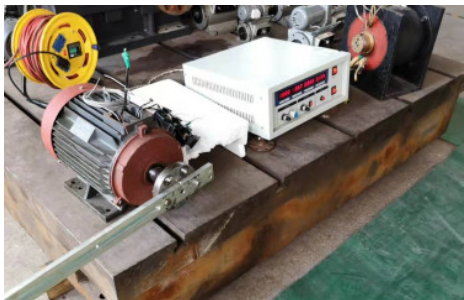
Figure 26. The inductance test of the prototype.